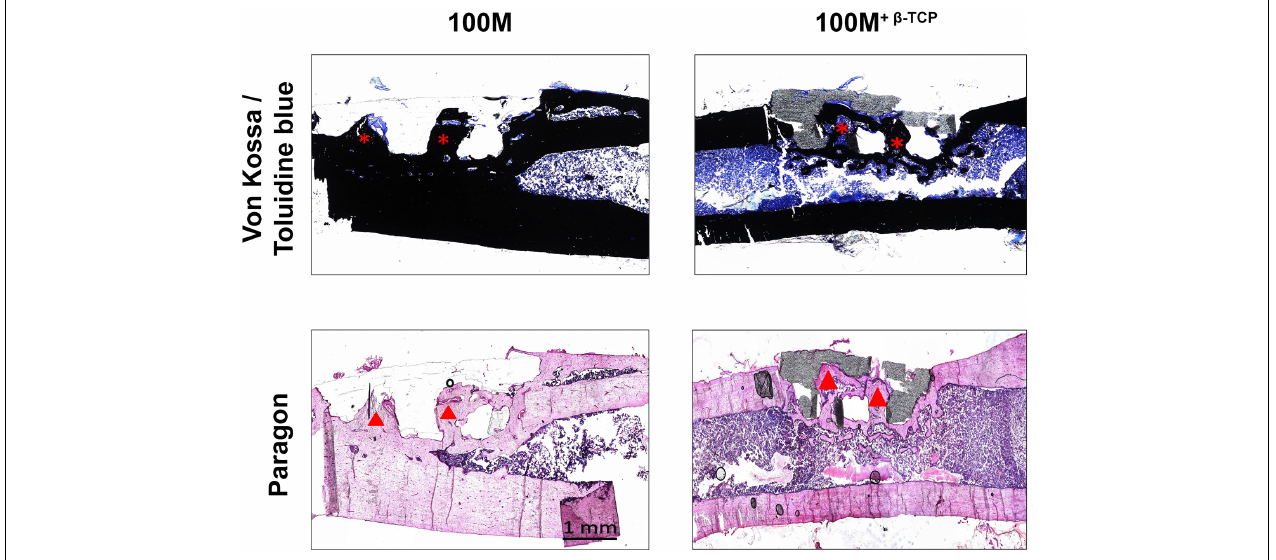
FIGURE 9 | Histological evaluation of implanted scaffolds. Histological sections of un-decalcified bone stained with Von Kossa and toluidine blue (VK/TB) to distinguish mineralized (black) from un-mineralized tissue (blue) were prepared (top panels). Representative mid-sagittal images show mineralized tissue surrounding the implants and inside of their pores (asterisks). In line with the micro-CT findings, a greater quantity of mineralized tissue was observed surrounding the 100M + β - TCP implanted scaffolds. Paragon staining (lower panels) showed significantly higher osteoid content in the interface between mineralized tissue and scaffold (dark pink line, arrowheads). Images were obtained at 2.5 × magnification and are representative of N = 8 100M and N = 16 100M + β - TCP scaffolds at 6 weeks